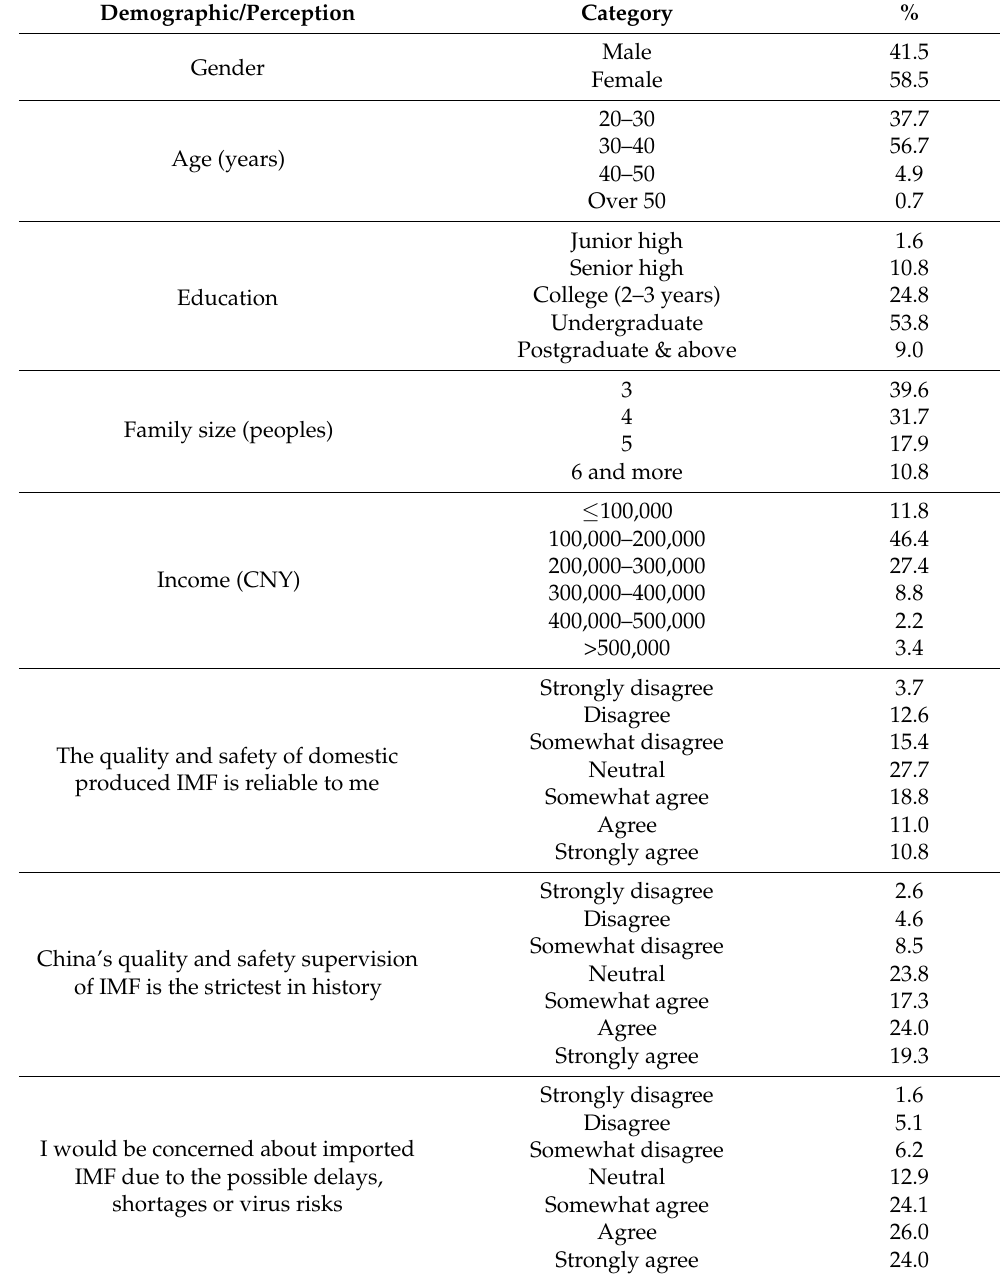
Table 2. Demographic frequency distribution of samples ( N =